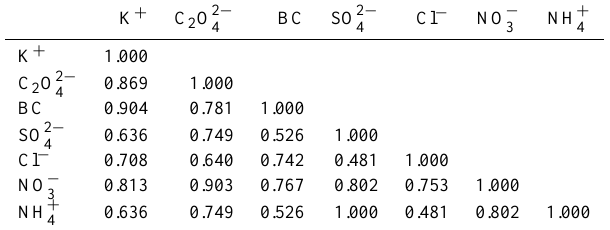
Table 9. Correlation coefficients between K + and other species in aerosols in summer at